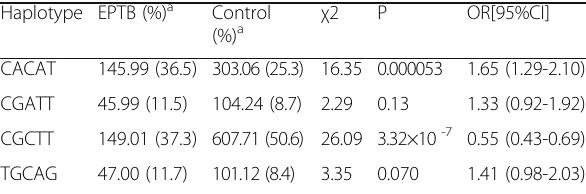
Table 6 Estimated frequencies of haplotypes consisting of EREG SNPs in EPTB and